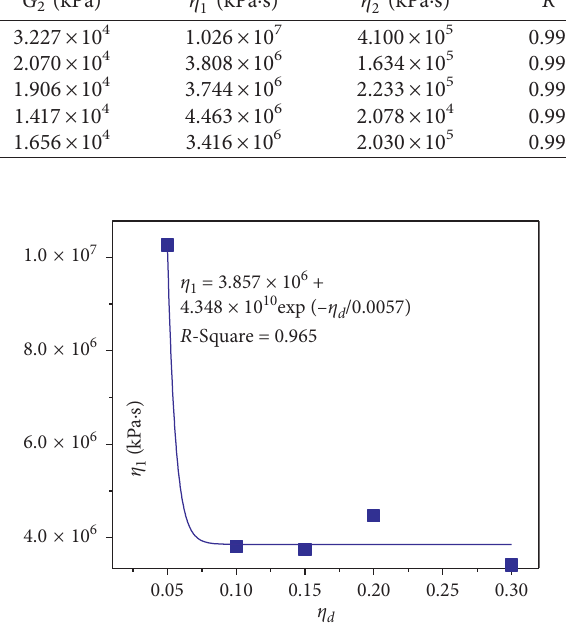
Figure 16: Relationship between η